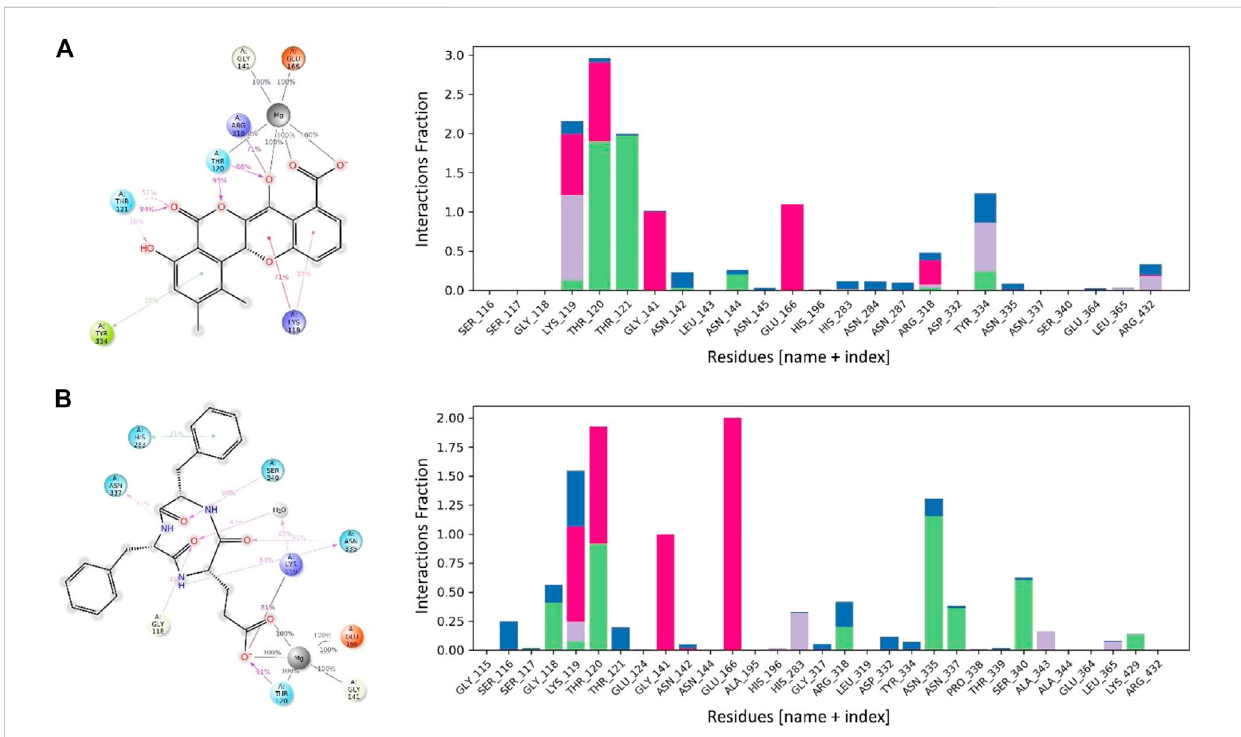
FIGURE 8 The interaction patterns and fractions of MurF protein in complex with (A) Maduralactomycin A and (B) Natalenamide C through the simulation period. The Histogram plot shows the fraction interaction of each residue, and the colour codes show the type of interaction, i.e., the green colour represents hydrogen bonds, the grey colour represents hydrophobic interactions, the purple colour represents ionic interactions, and the blue colour represents the water bridges.